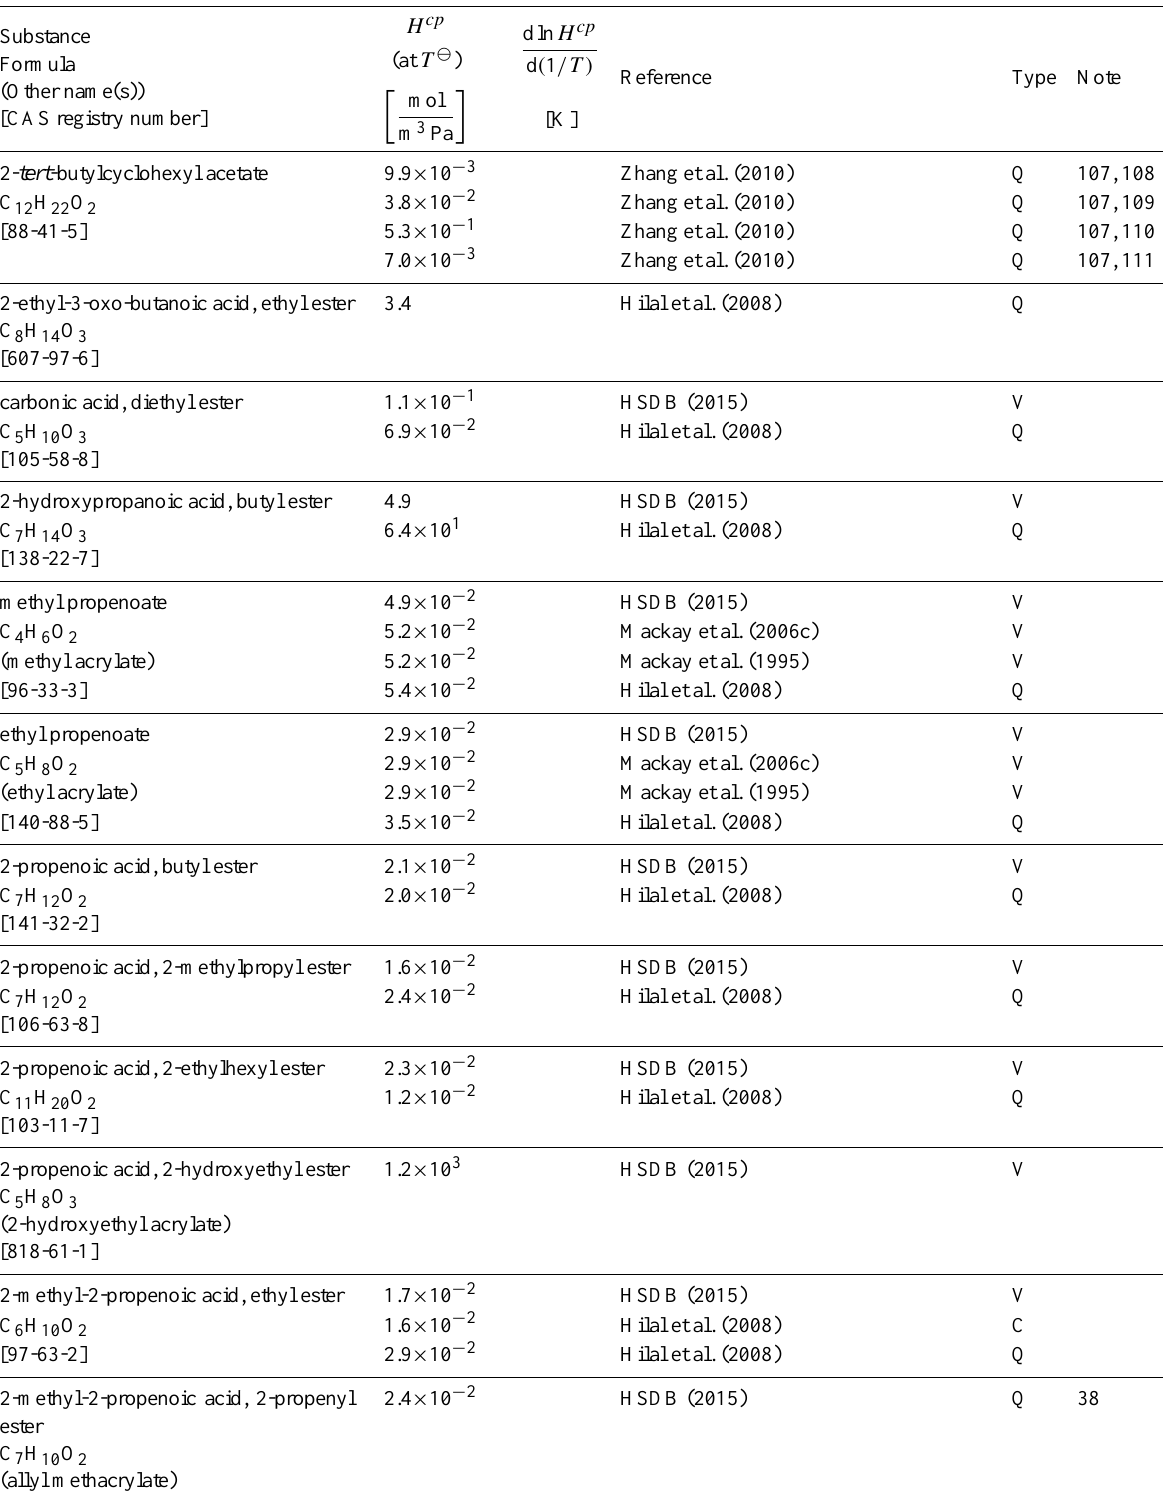
Table 6: Henry’s law constants for water as solvent